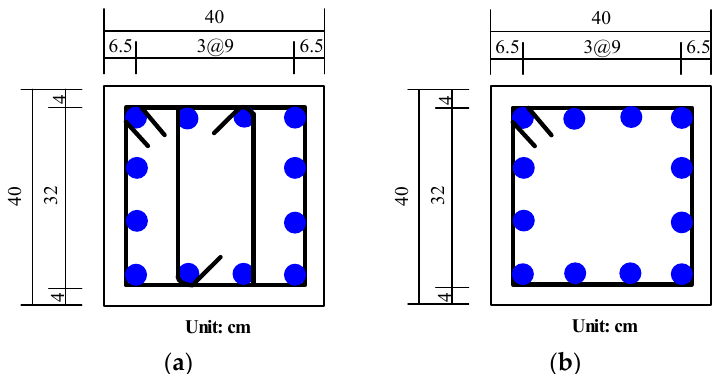
Figure 2. Detailed arrangement of the reinforcements of the specimen in Chiu et al. [7]. ( a ) Flexural failure (FF) (S = 150 mm); ( b ) flexural-shear failure (FSF) (S = 150 mm), shear failure (SF) (S = 300 mm).